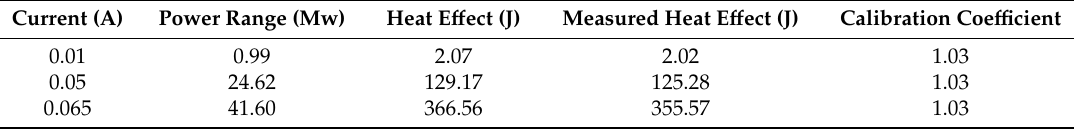
Figure 7. The heat flow rates for joule effect calibrations. Table 2. Calibration coefficients for different heat flow rates.